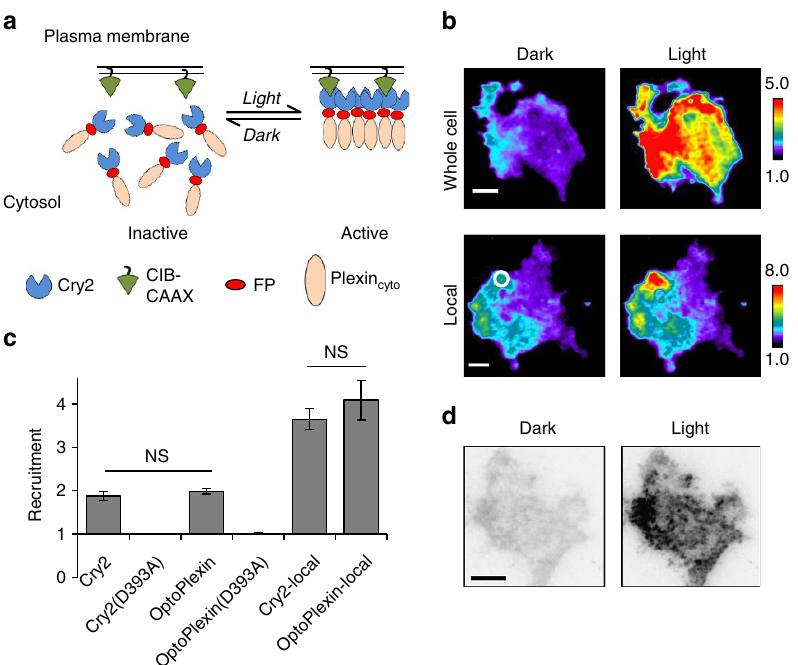
Figure 2 | Design and characterization of optoPlexin. ( a ) Cartoon representation of the optoPlexin design (see main text). FP, fluorescent protein; Plexin cyto , cytosolic domain of Plexin-B1. ( b ) TIRF images showing the plasma membrane recruitment of mCherry-optoPlexin in COS-7 cells after 1min of whole cell or local illumination (440nm and 50ms pulse at 0.1Hz, unless otherwise stated). Scale bar, 10 m m. White circle, region of illumination. ( c ) Quantification of the recruitment levels of Cry2, Cry2(D393A), optoPlexin and optoPlexin(D393A) on whole cell or localized blue light illumination